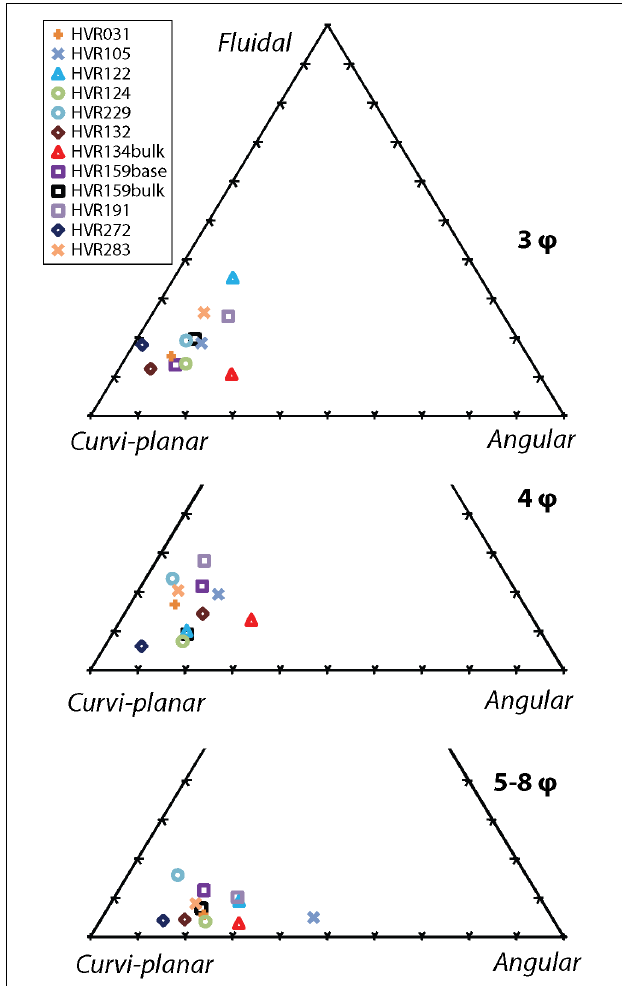
FIGURE 8 | SEM point-count componentry data for 3 ϕ , 4 ϕ , and 5–8 ϕ grainsize fractions. The proportion of fluidal, angular, and curvi-planar particles from natural samples composed dominantly of glassy vesicular clasts (S1 and S2) are shown. Samples show a decrease in the proportion of fluidal ash with decreasing grainsize, and a corresponding increase in angular